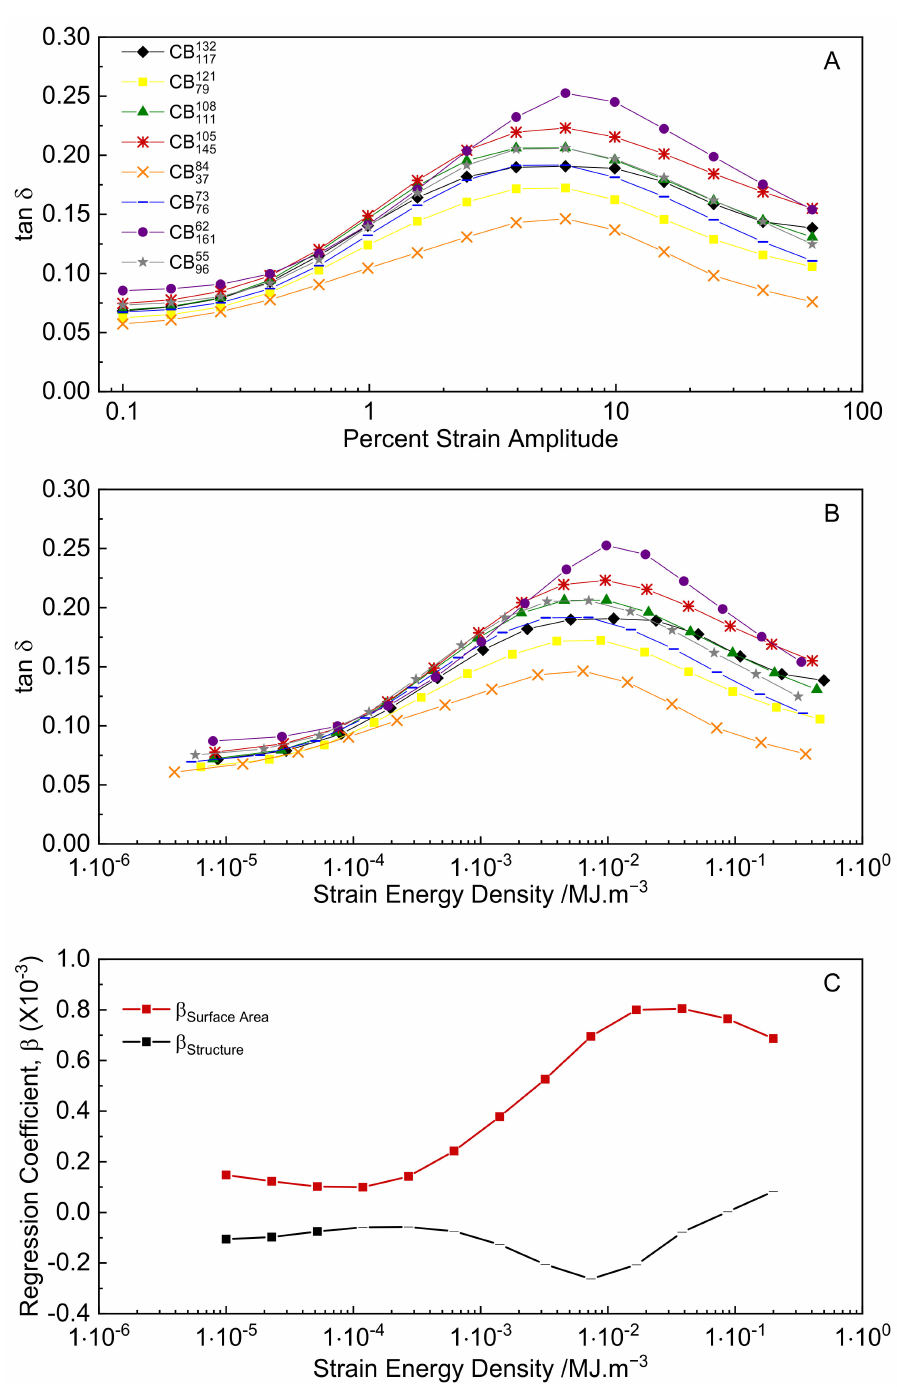
Figure 9. ( A ) tan δ versus strain amplitude; ( B ) tan δ versus peak dynamic strain energy density; ( C ) multiple regression coefficients for structure and surface area versus peak dynamic strain energy density (points with p values > 0.05 are shown as